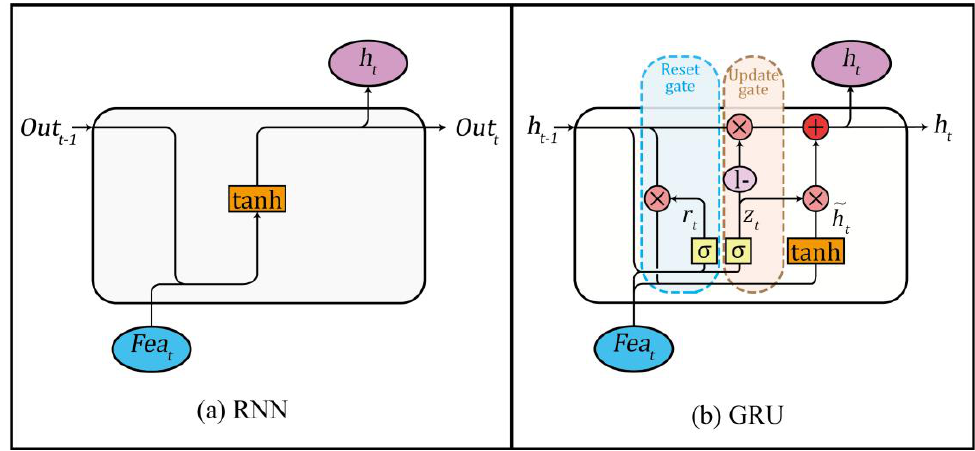
Figure 3. The architecture of ( a ) RNN and ( b ) GRU.